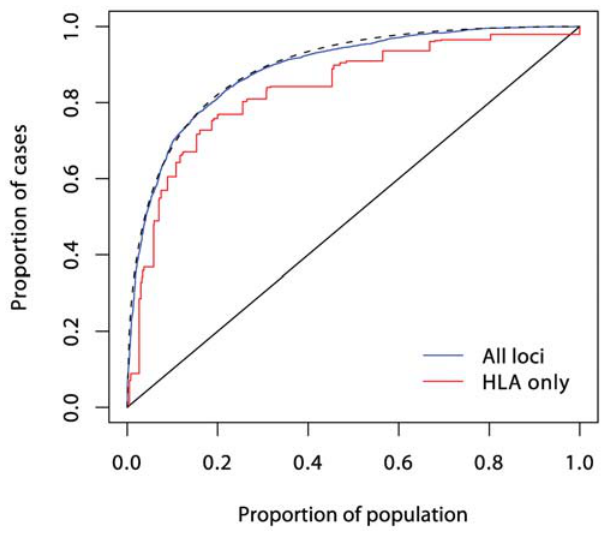
Figure 5. ROC curve prediction from all the SNPs listed in Supplementary Table 1 in Text S1 (in blue). The prediction curve using the six MHC SNPs alone is shown in red, and the dashed curve corresponds to a polygenic multiplicative model with l s =4.75.